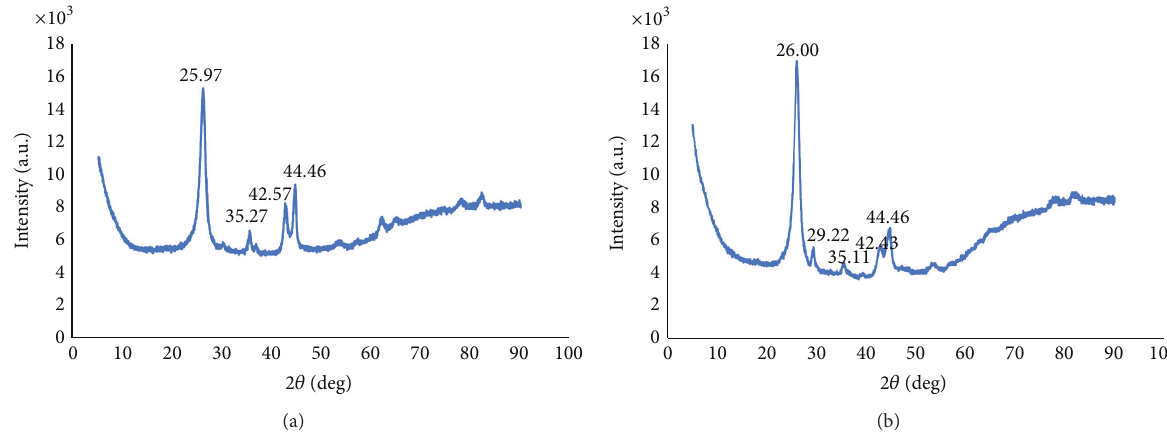
Figure 5: X-ray diffraction spectra (XRD) of nanomaterial synthesized from (a) Fe/Co supported on magnesium oxide and (b) Fe/Co supported on calcium carbonate.